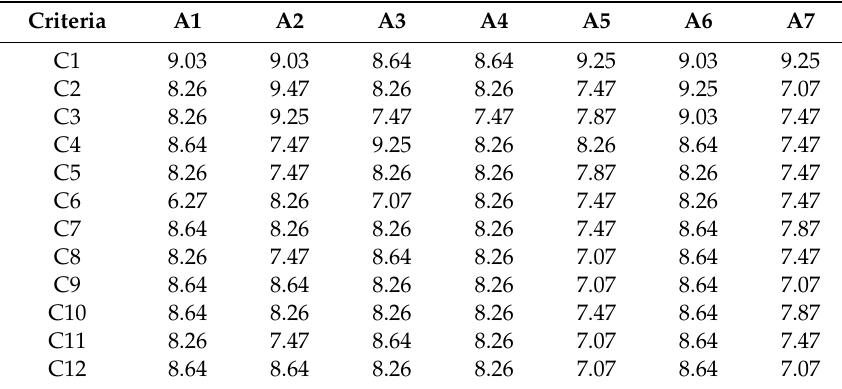
Table 9. Defuzzified decision matrix.